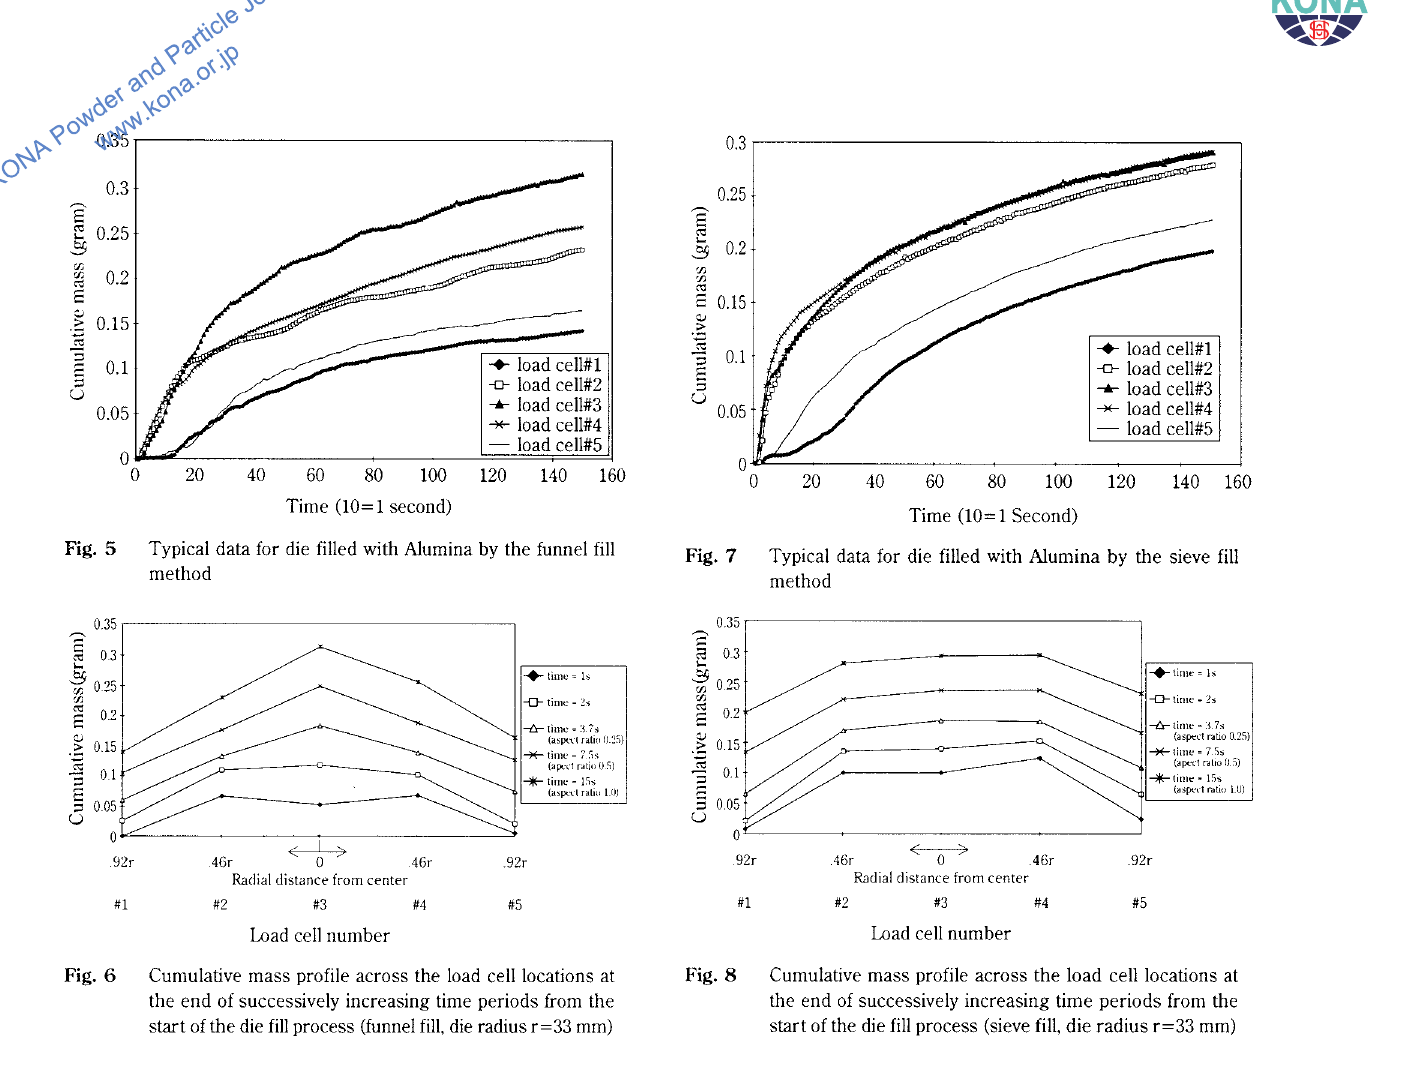
side (±0.46r, load cell #2 and #4) recorded the next two highest readings. The two load cells near the walls of the die (±0.92r, load cell #1 and #2) recorded